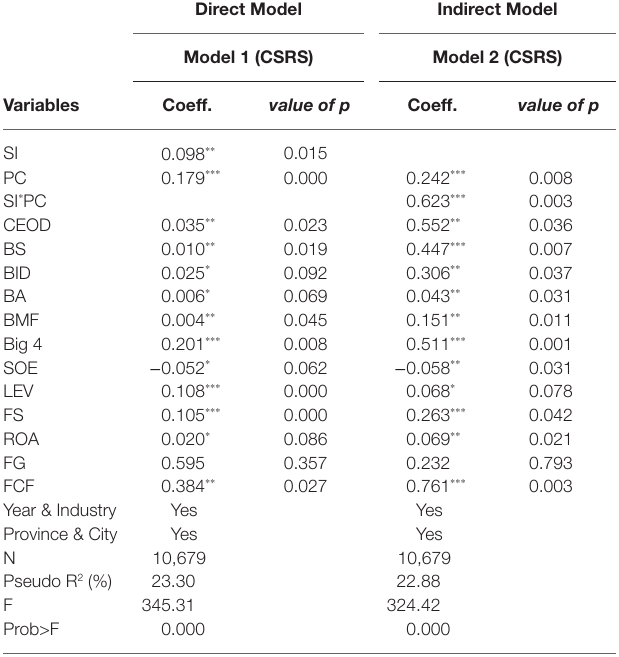
TABLE 10 | Propensity score